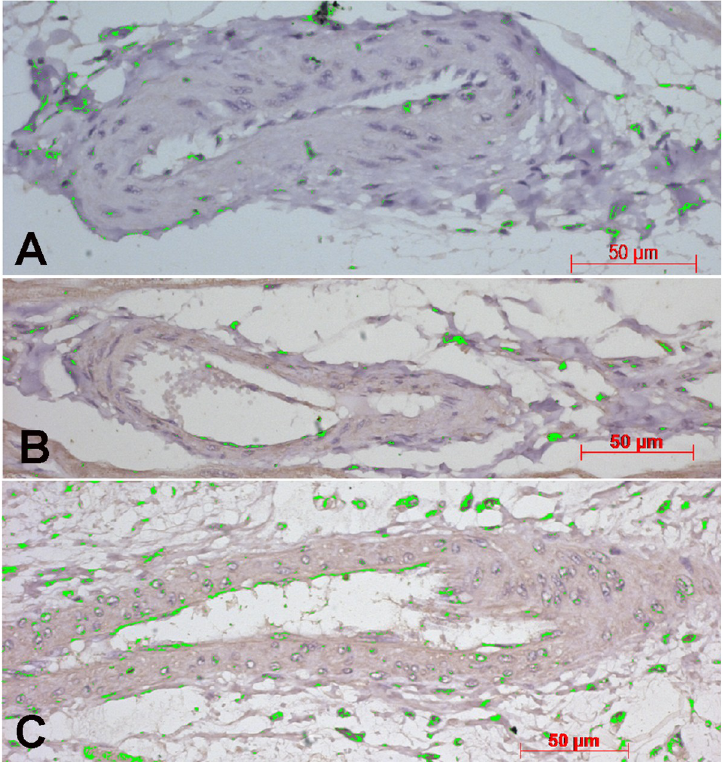
Fig 4. Photomicrographs of the myocardium from animals of the three groups submitted to immunohistochemical staining for vascular endothelial growth factor (VEGF). The panels show the automatic colour detection of vascular and perivascular positive cells in myocardial tissue labeled with anti-VEGF antibody (green color). The area occupied by labeled cells (area fraction) was calculated relative to the total perivascular area, as shown in Fig 1. Panel A shows a control case, while in panels B and C are examples of trained animals (B: Continuous group; C: Intermittent group). Scale bars in all the panels corresponds to 50 micrometers.